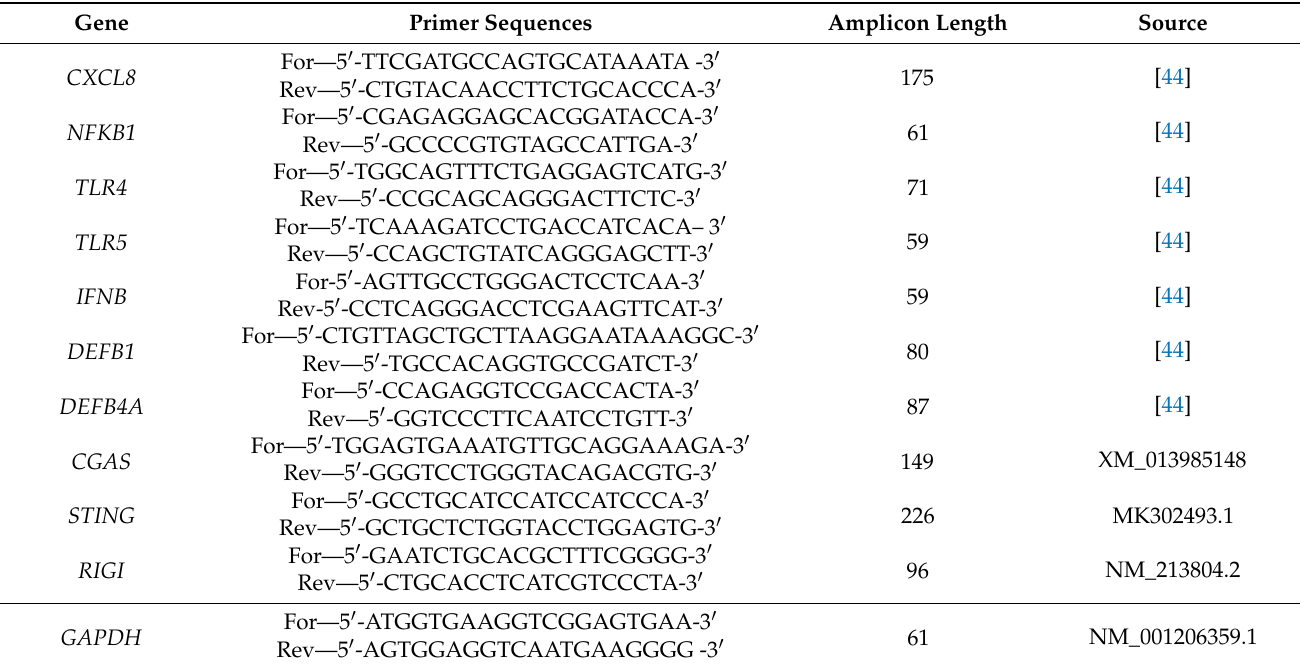
Table 1. Primer set sequences for target genes and